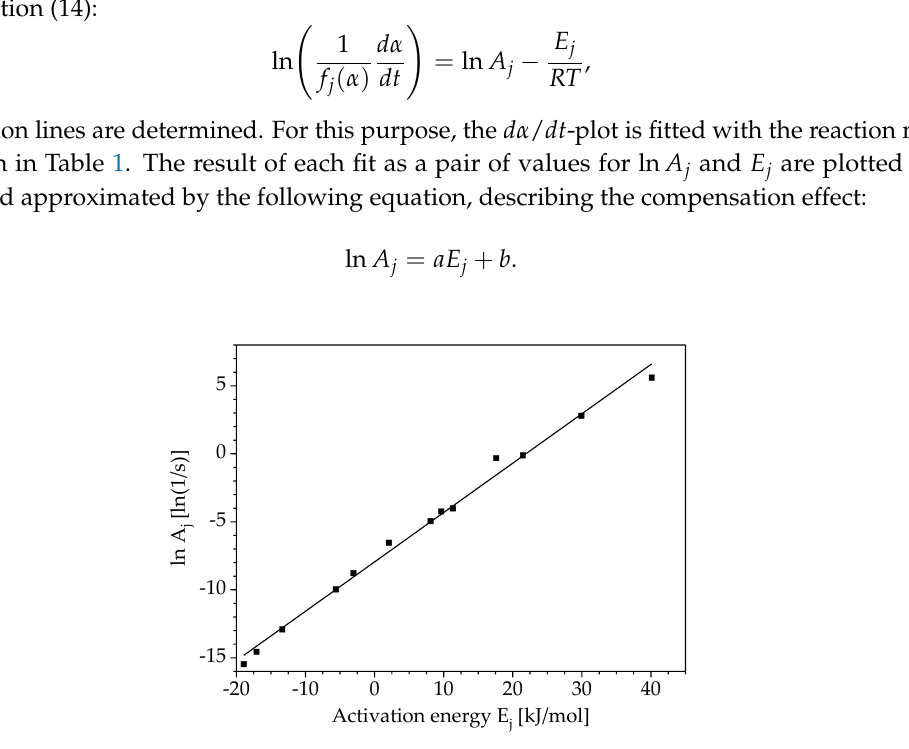
Figure 2. Exemplary illustration of a compensation line of a polyurethane resin (PUR) for a defined heating rate 𝛽 = 3 °C/min applying the models 1–13 from Table 1.